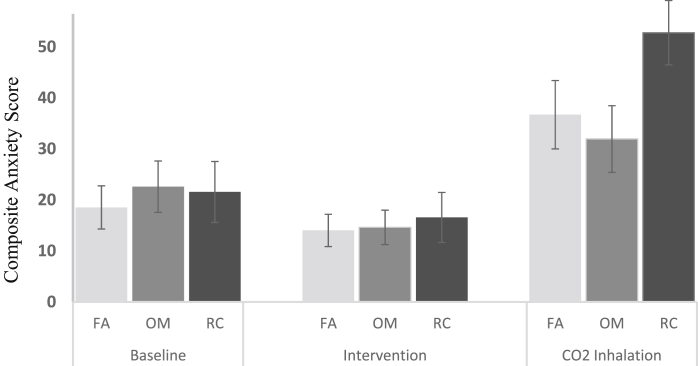
Effects of FA, OM and RC on CO2 increased anxiety, F(4,58) = 3.19, p = .020 ηP2 = .18, 90% CI = .02 to .28.